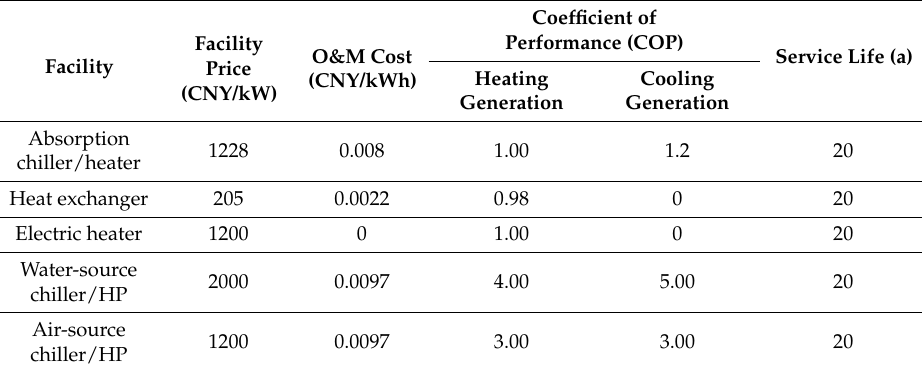
Table 2. Parameters of energy conversion facility [14,39,61].